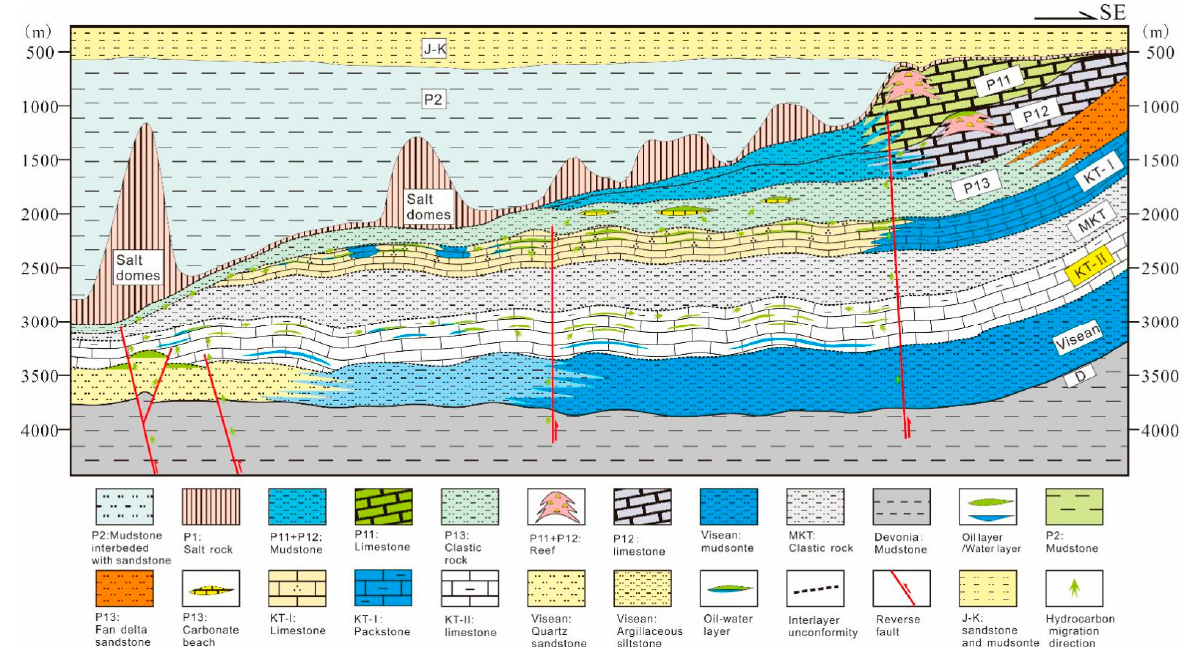
8 of 15 Figure 4. Tectonic settings and location of Central Block.